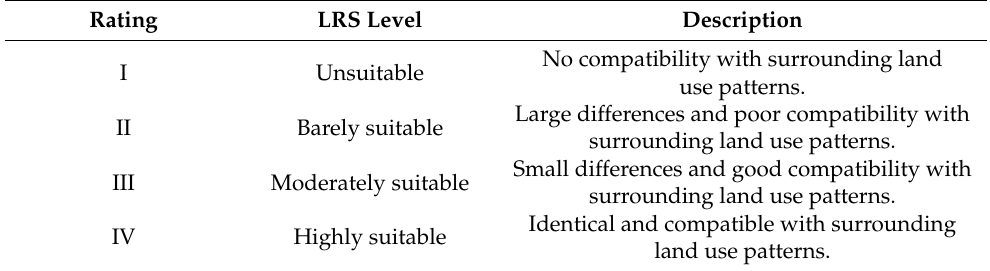
Table 7. LRS ratings and their